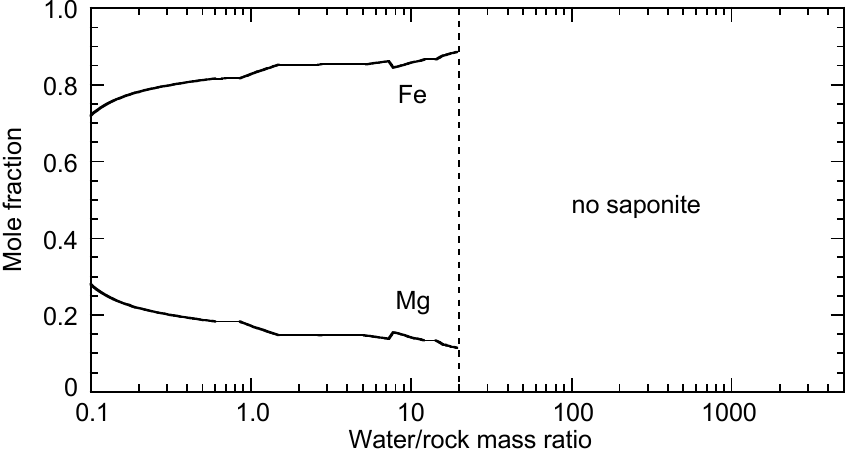
Figure A1. Mole fractions of saponite as a function of water-to-mass ratio when rock reacted with O 2 -bearing initial fluid (Case I-SG) at 5 °C.